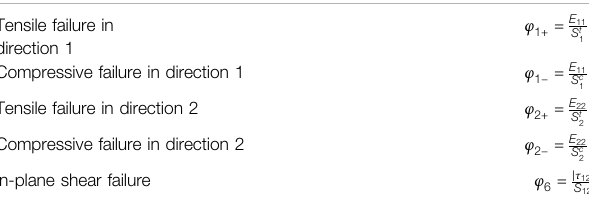
TABLE 2 | Damage activation functions for a composite ply (Muñoz et al., 2015).